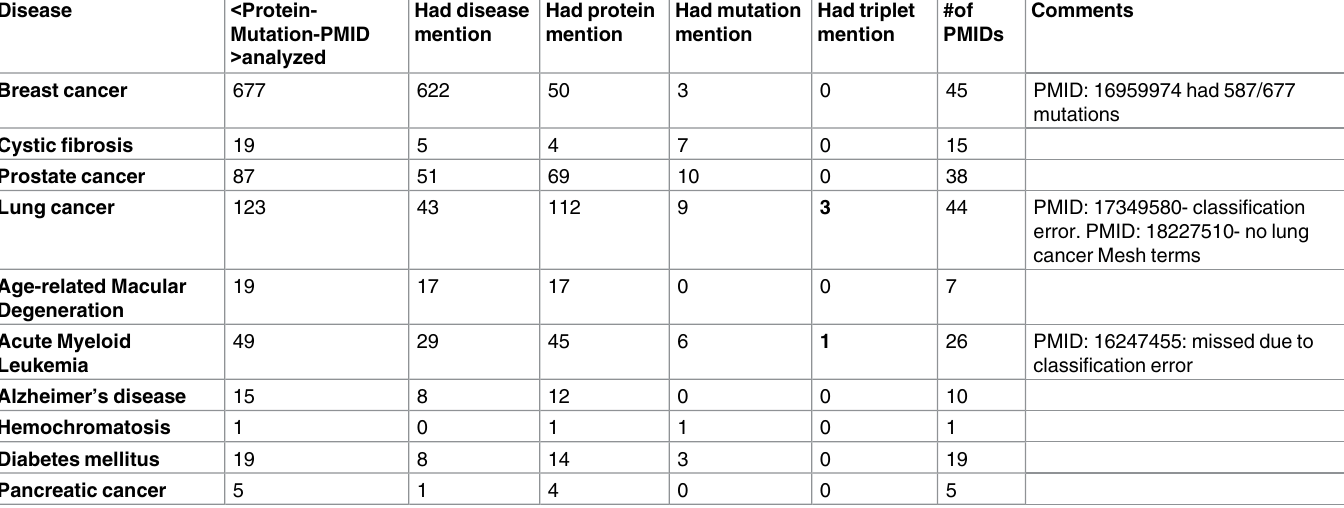
Table 3. Analysis of missed mutations.